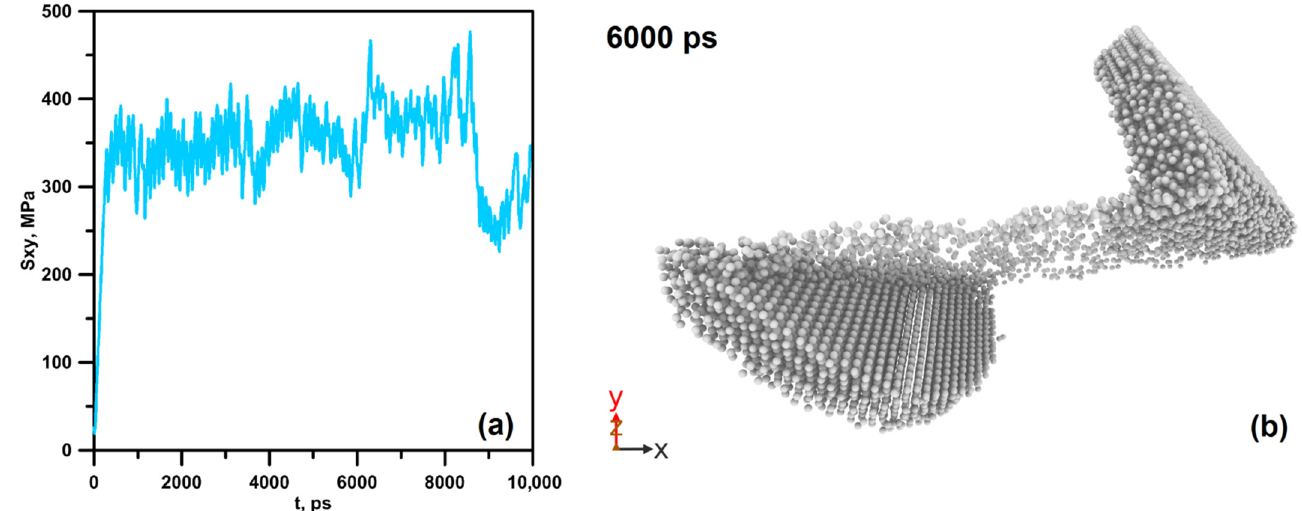
Figure 8. Time dependence of averaged shear stress in a system containing θ ’ phase of 18 nm in diameter. ( a ) View of inclusion after multiple interactions with dislocation ( b ) Thickness of system is 27 nm, displacement velocity is 3 m/s and temperature is 300 K.